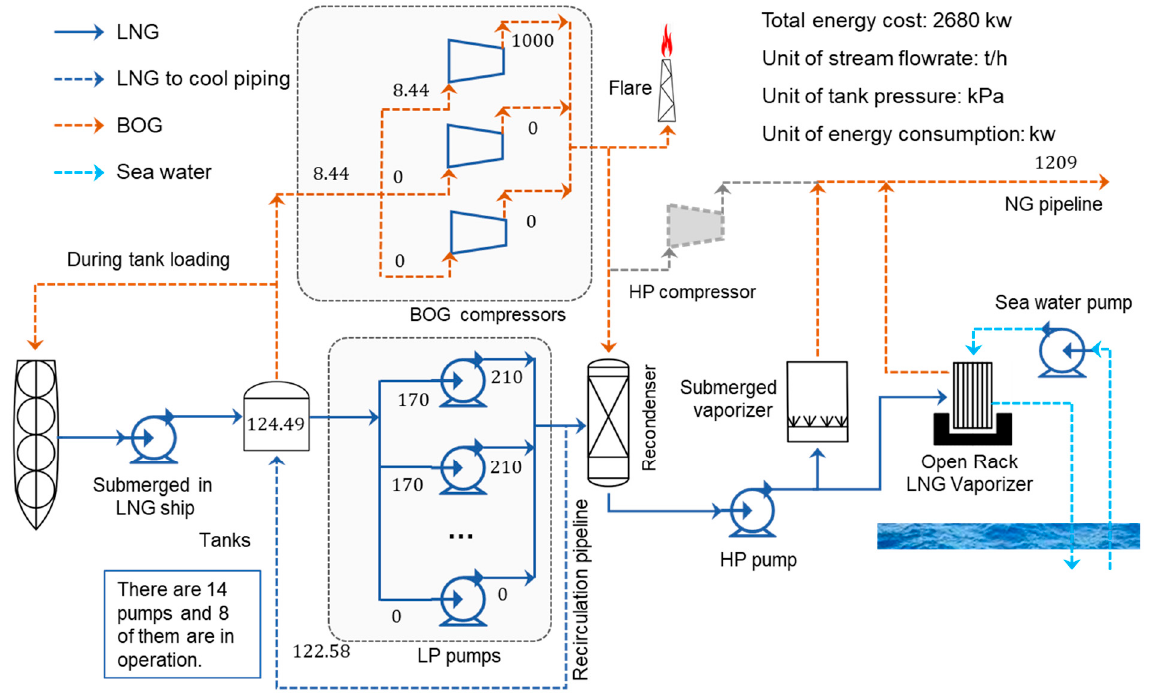
Figure 5. Optimized system configuration determined by the model (operational optimization model for the LNG terminal (LNGT-OOM)). Table 9. Optimized results and energy consumption of the model